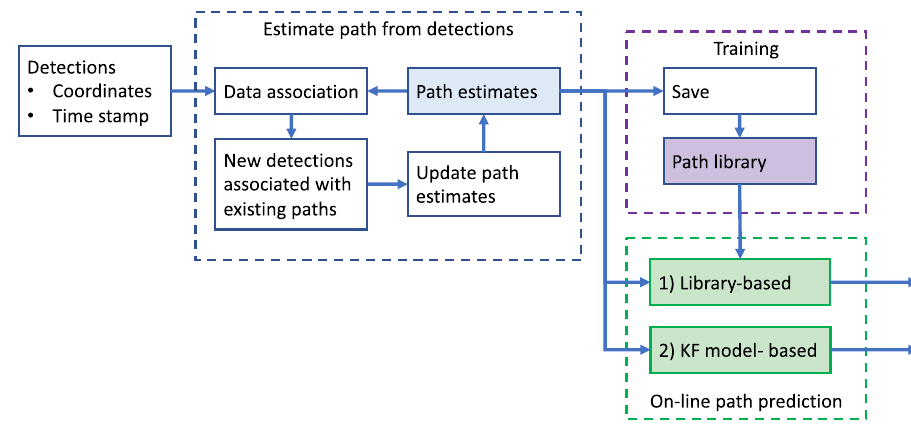
Figure 1: Main functional blocks of the path prediction